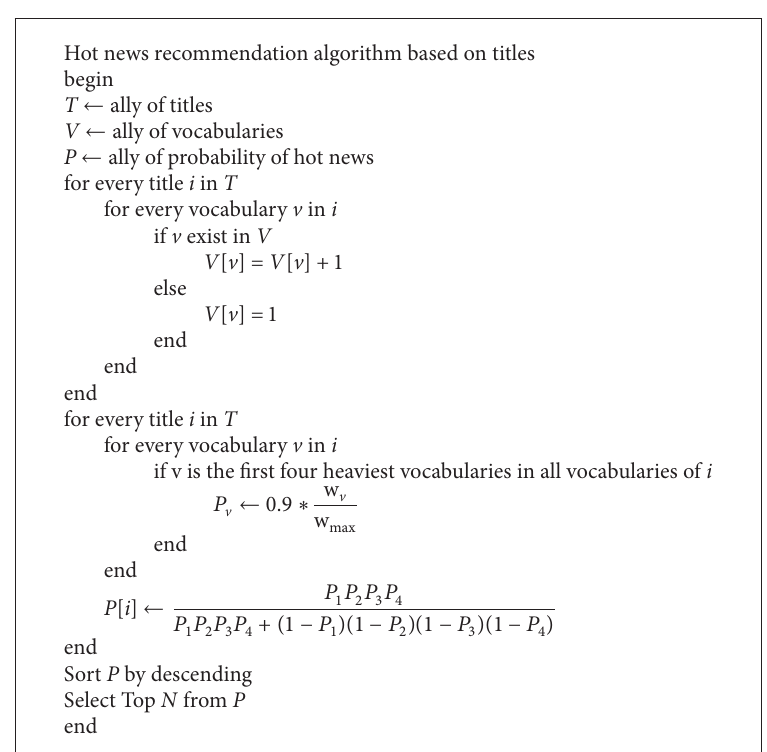
Algorithm 1: Hot news recommendation